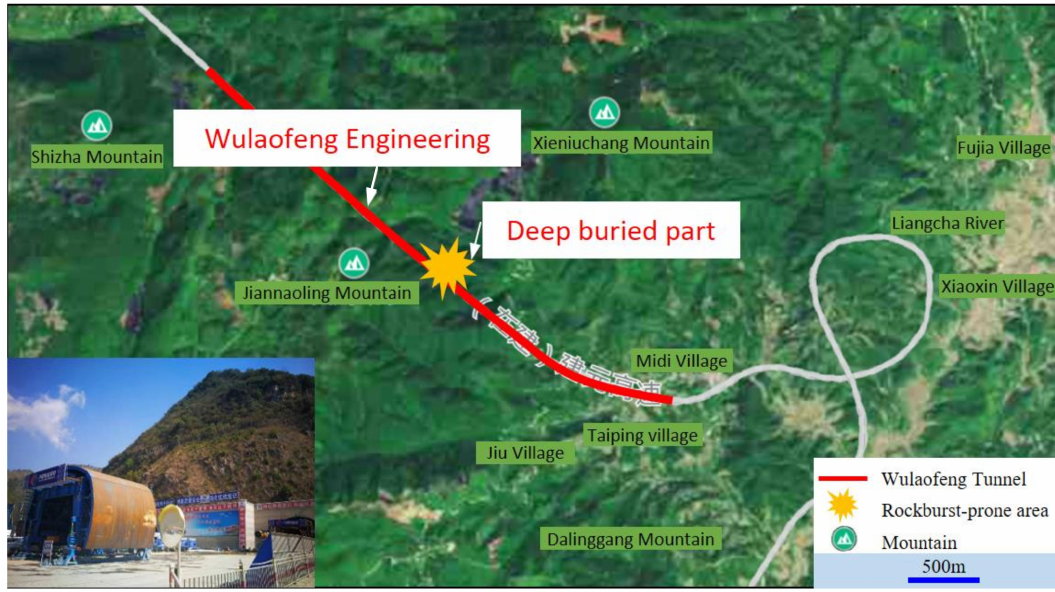
Figure 1. The geographical location of Wulaofeng